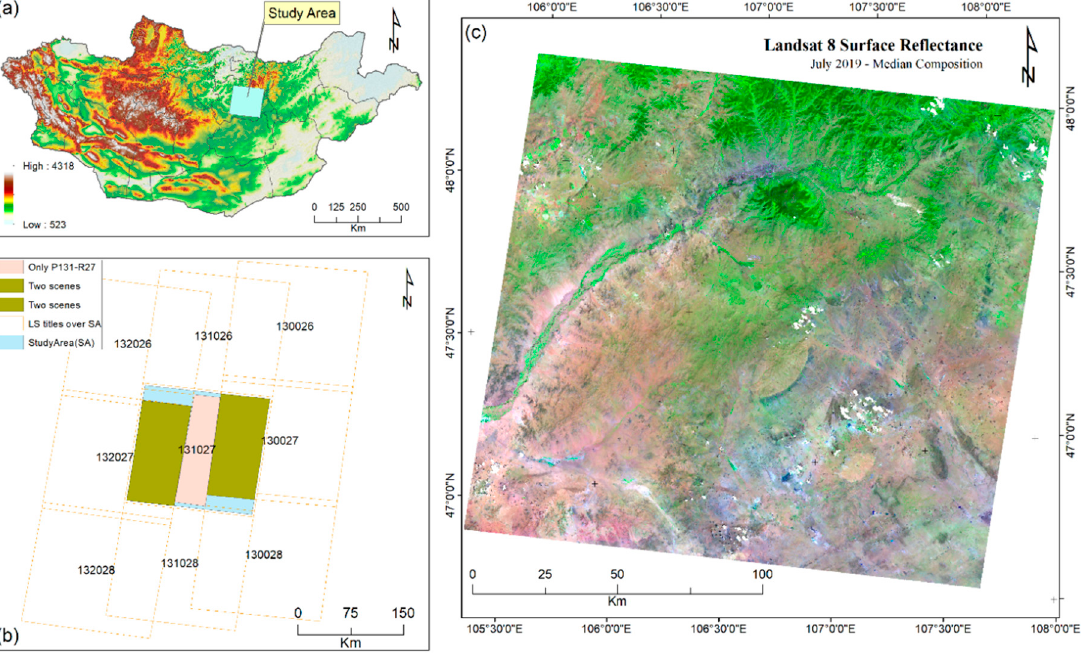
Figure 2. ( a ) The location of the study area in Mongolia with elevation derived from SRTM (30m) data, ( b ) The Landsat scenes over the study area—different colors represents different numbers of Landsat scenes covering the study area, ( c ) Natural composite (7-5-3) of the median image in July 2019 of the study area.